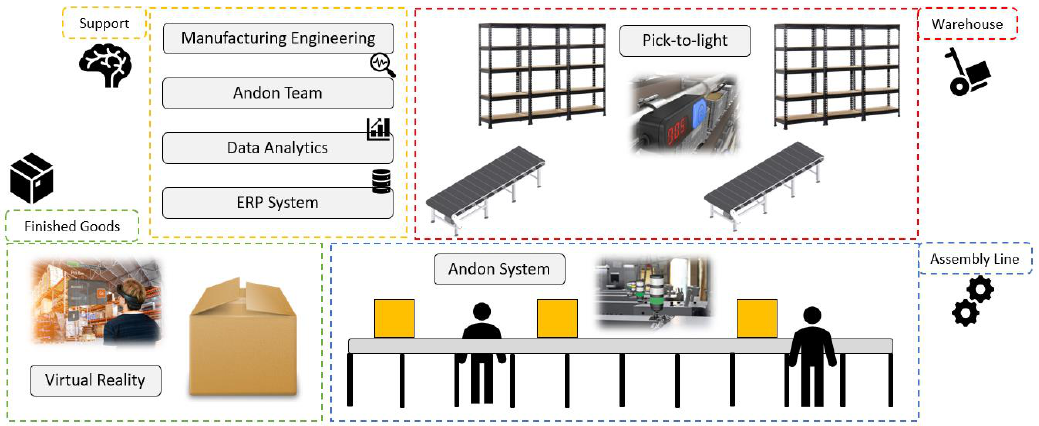
Figure 6. Overview of the Smart Assembly Line.